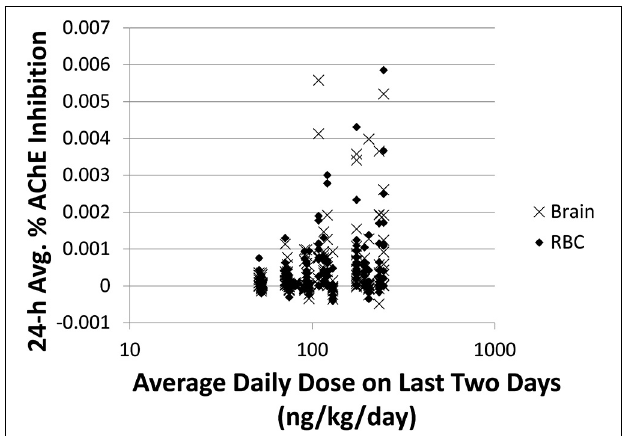
FIGURE 4 | Time-averaged (over 24h) % AChE inhibition for brain (x) and RBC ( ♦ ) vs. average daily doses ≥ 50ng/kg/day from the last 2 days for 5000 simulations. For brain: slope = 0.0012, R 2 = 0 . 089. For RBC: slope = 0.0011, R 2 = 0 .